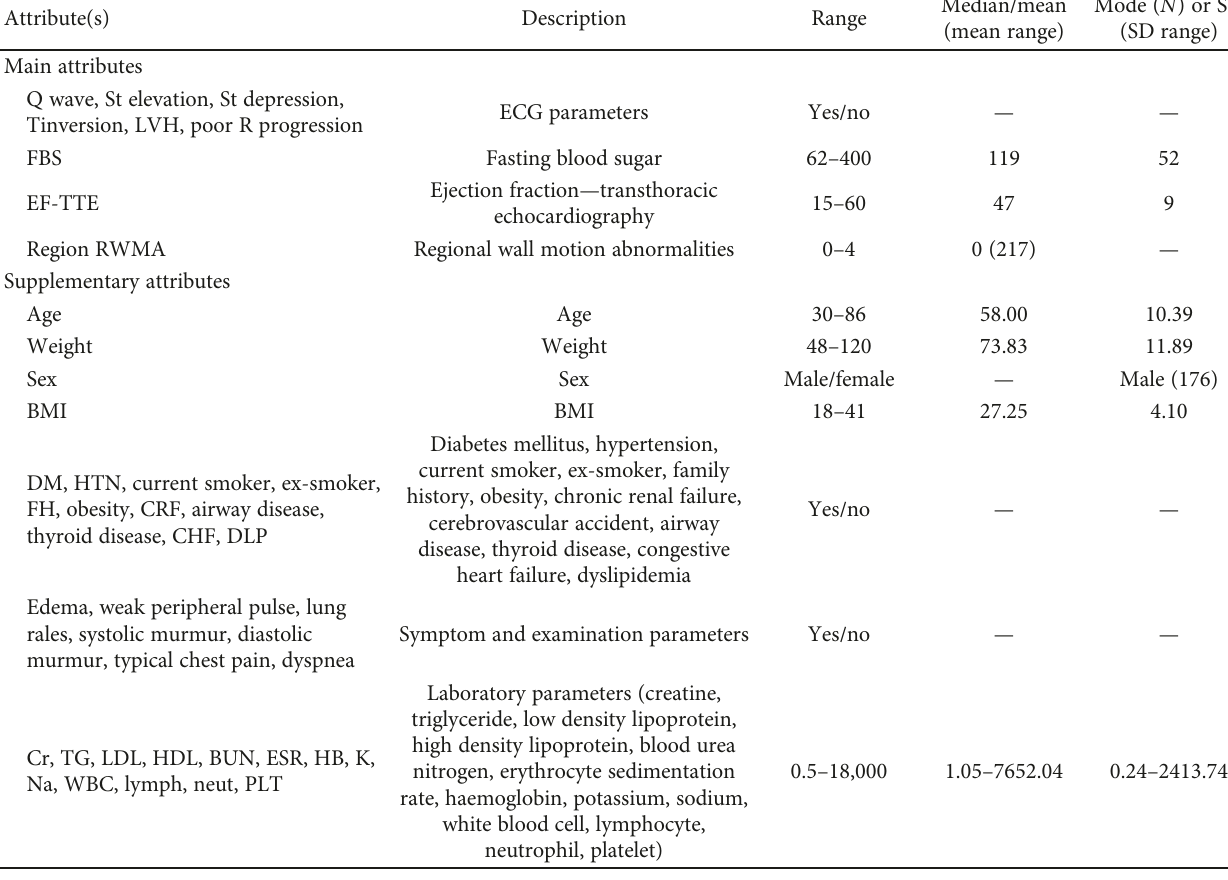
Table 4: Characteristics of attributes for the “ CORONARY ” dataset.